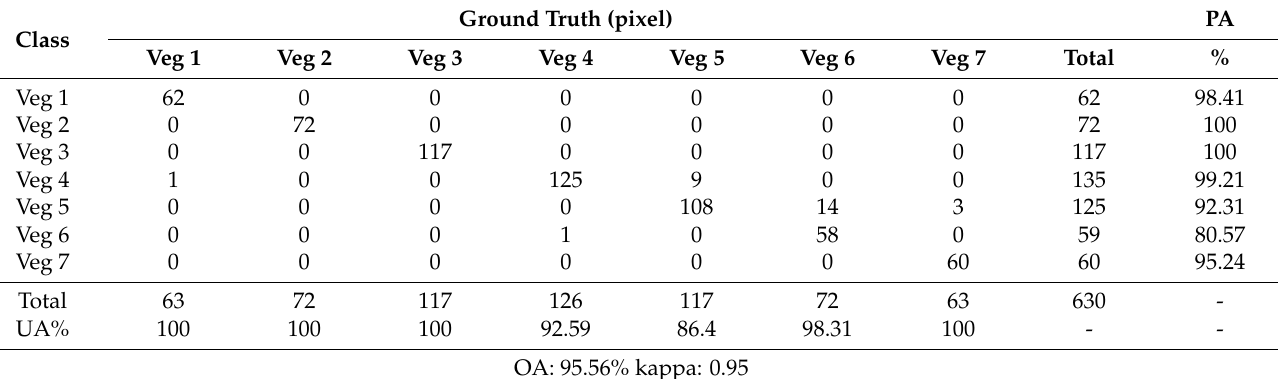
Table 6. Confusion matrix for the classification results of the knowledge decision